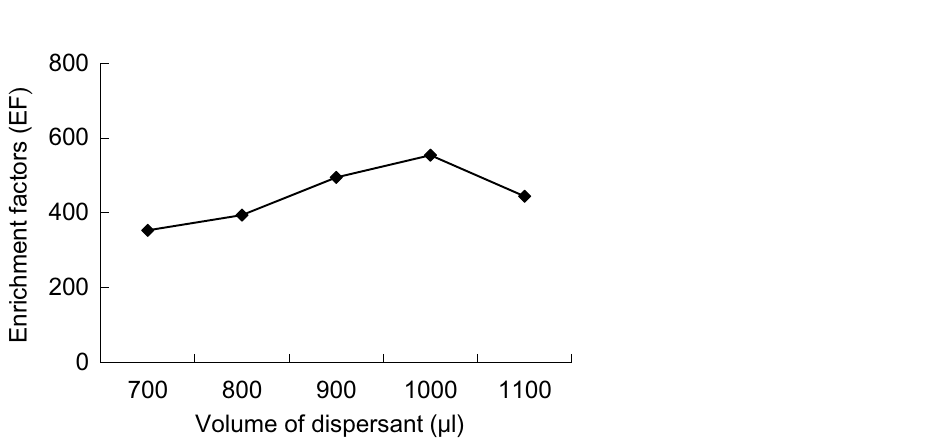
Figure 8. Enrichment factors of different volume of